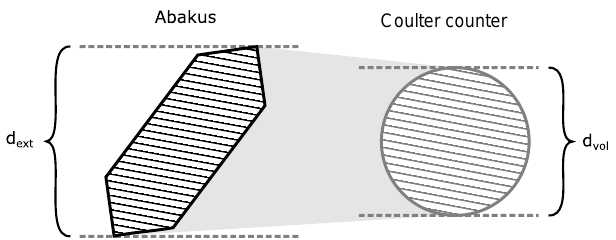
Figure 1. The Abakus measures the extinction cross section of the particles, while the Coulter counter measures their volume. Both instruments convert this to an equivalent diameter, d ext and d vol ,